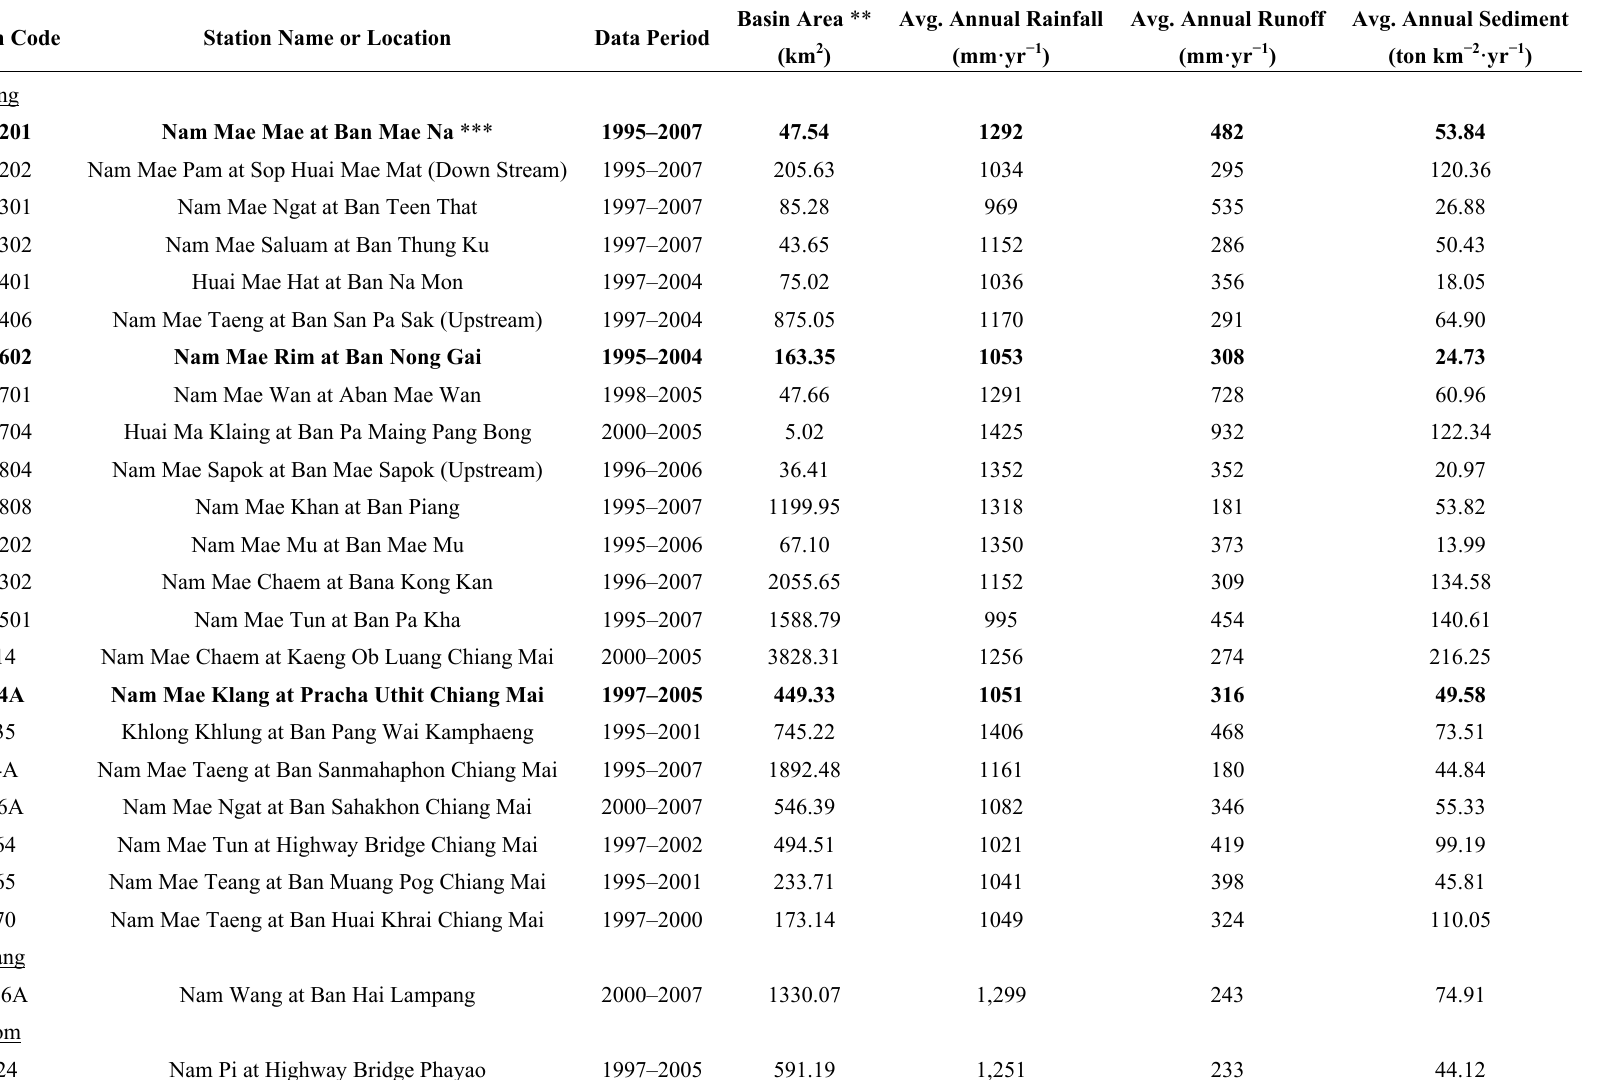
Table 2. List of suspended sediment gauging stations in this